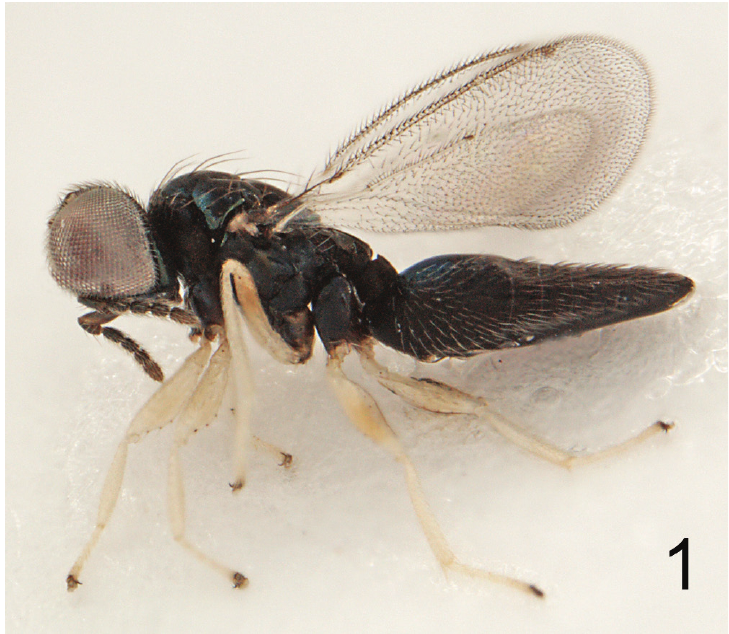
Figure 1. Horismenus liturgusae sp. n. female, habitus, length of specimen 2.1